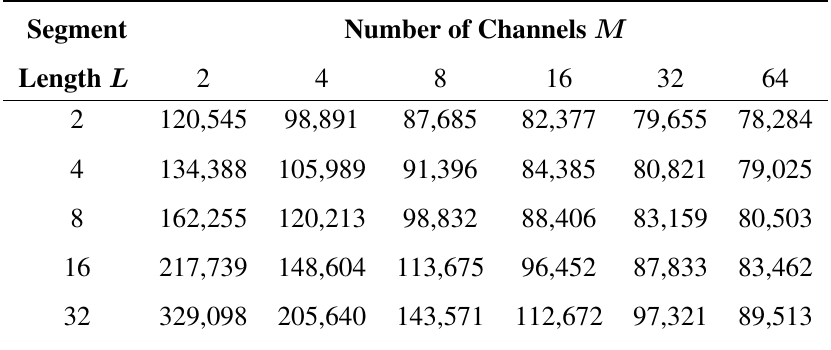
Table 4. The normalized area ( µ m 2 /ch.) of the proposed circuit for different numbers of channels M and segment lengths L